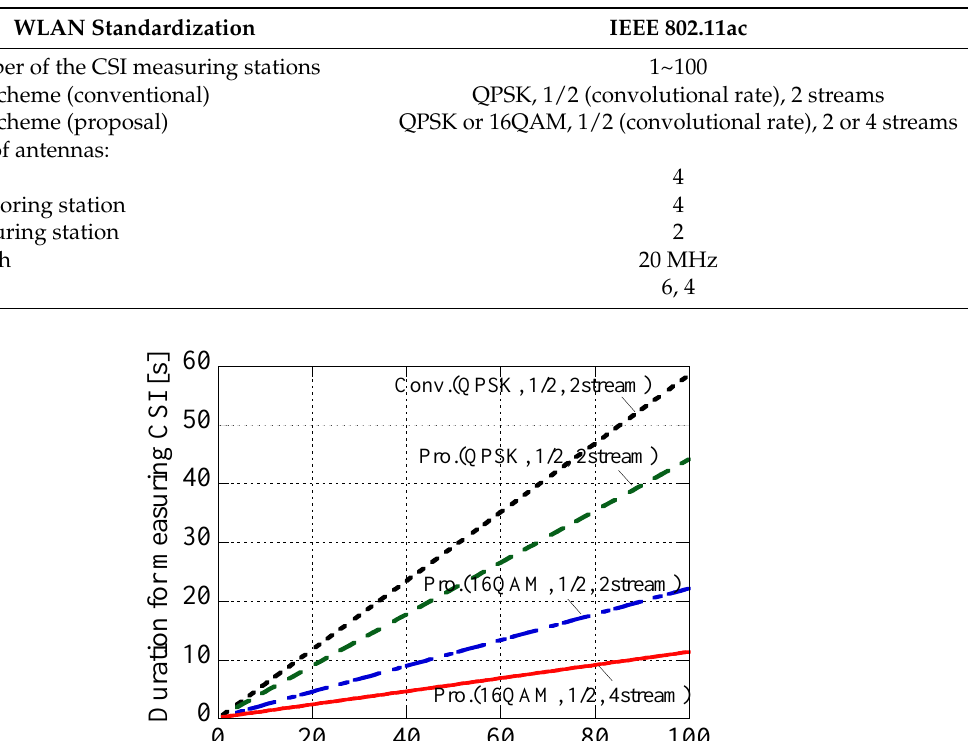
Table 3. Simulation parameters.